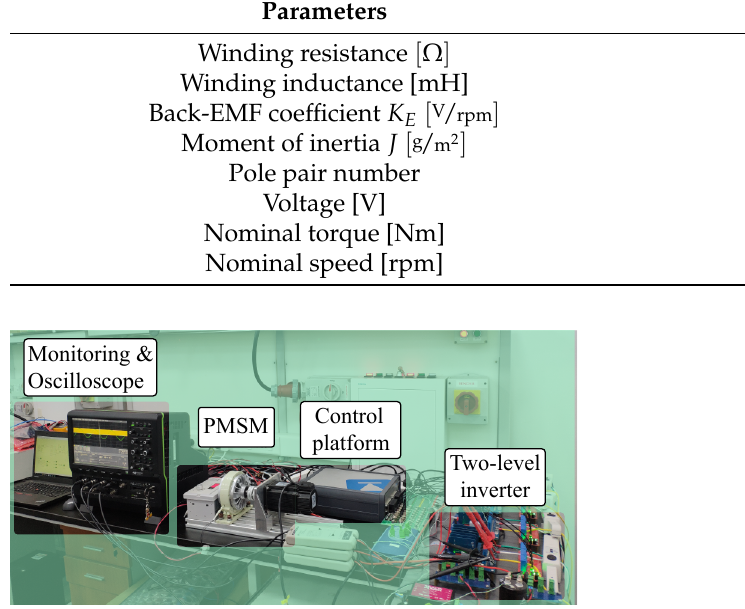
Figure 9. Down-scaled 750 W three-phase PMSM laboratory prototype.